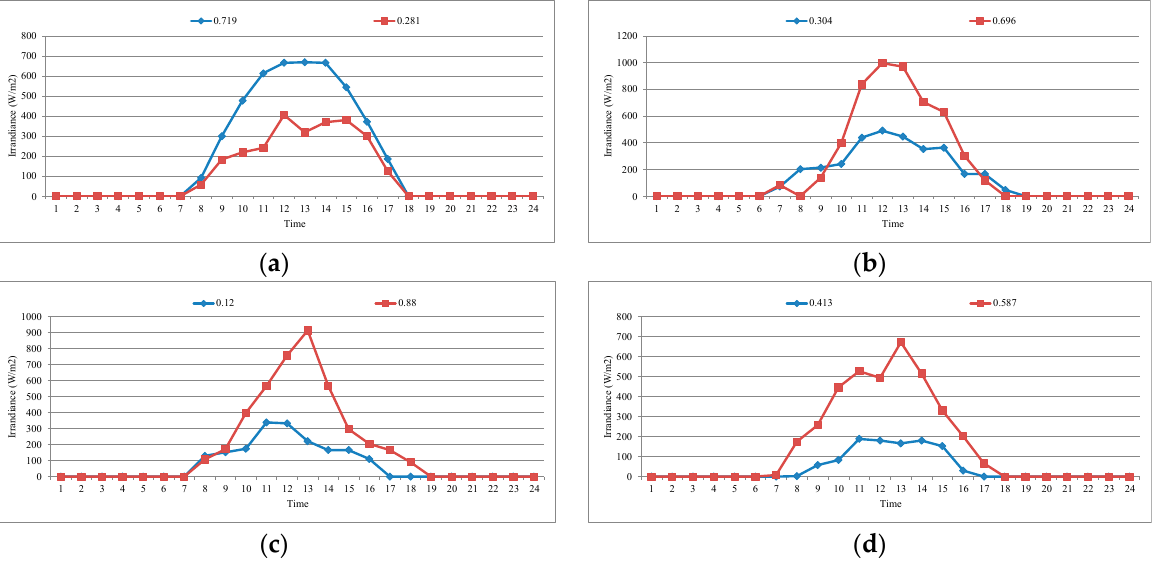
Figure 2. Representative irradiance profiles for four seasons. ( a ) Representative irradiance profiles for the spring season; ( b ) the representative irradiance profiles for the summer season; ( c ) the representative irradiance profiles for the autumn season; and ( d ) the representative irradiance profiles for the winter season.